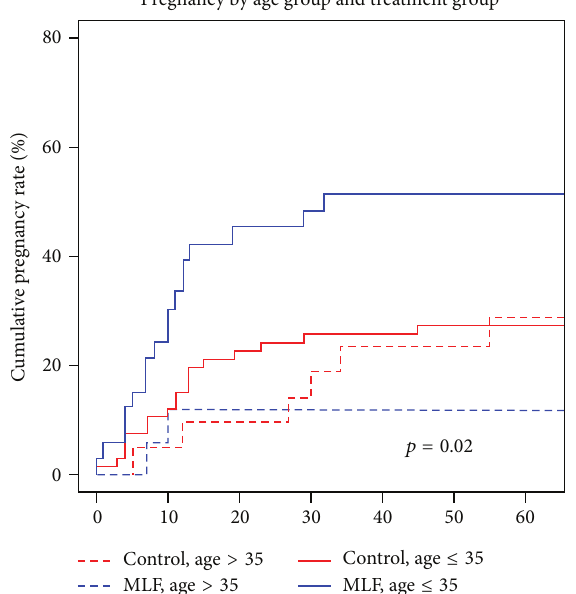
Figure 3: Pregnancy rate by treatment (MLF versus control) and age (women ≤ 35 ys, women > 35 ys) over time. Significant difference for women ≤ 35 ys ( 𝑝 = 0.02 ), no significant difference for women > 35 ys ( 𝑝 = 0.45